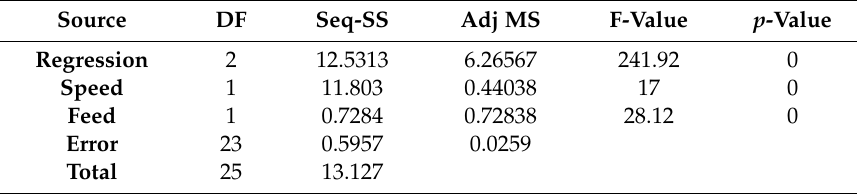
Table 5. Analysis of variance for transformed response for Sa (Tool 3).